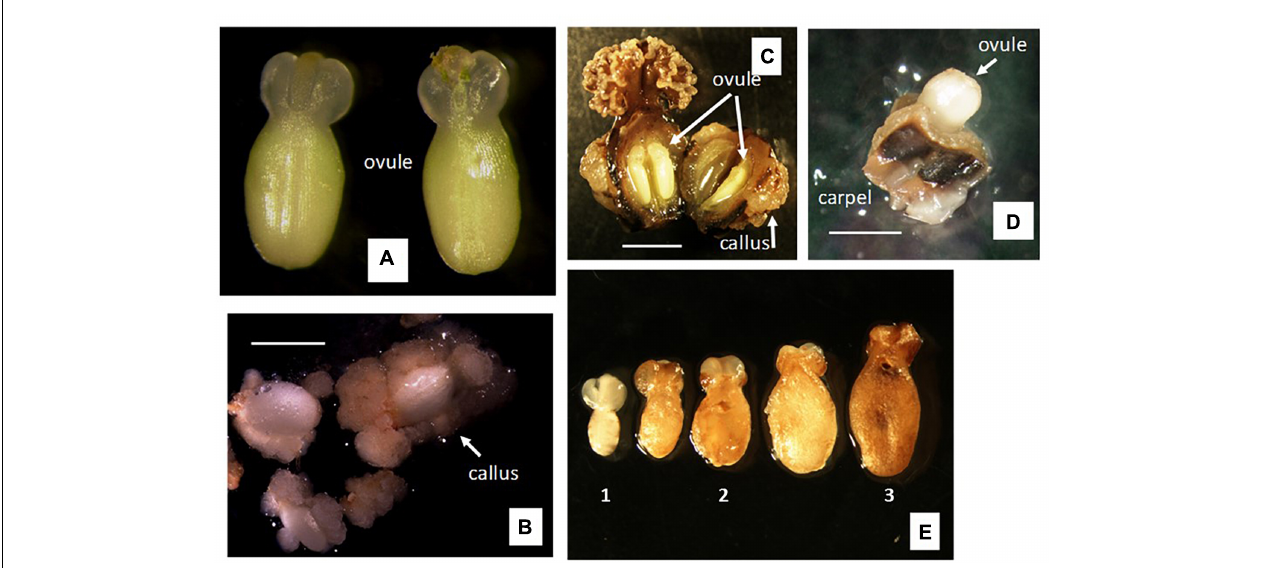
FIGURE 3 | Responses to gynogenesis induction of unpollinated female organs using different methods of culture. (A,B) Method A of culture, i.e., isolated ovule culture using single-step induction system. (A) Ovule dissected 1 day after anthesis (1 DAA). (B) Response after 4 weeks of culture on solid medium of ovules isolated as in (A) . (C) Method B of culture, i.e., ovary culture using single-step induction system. Left, pistil culture after cutting off the nectar gland ring. Right, ovary culture after cutting off the nectar gland ring and the stigma. Cultures spontaneously opened the ovary wall after 3–4 weeks of culture on solid medium, exposing ovules within ovary. (D,E) Method C of culture, i.e., carpel culture. Individual carpels cut off from the ovary and cultured containing one ovule each. (D) Ovule protruded out of the carpel wall after 3–4 weeks of culture on solid medium. (E) (1) Freshly dissected ovule from the cultured carpels as shown in (D) ; (2) ovule after 6 weeks of culture on solid F6 or BDS medium, using single-step induction system; (3) ovule after 6 weeks of culture on solid F6 or BDS medium, followed by 9 weeks on R medium, using two-step induction system. Bar = 5